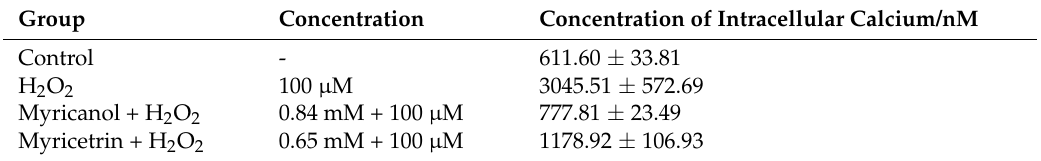
Table 1. Effect of myricanol and myricetrin on intracellular calcium shifts determined by Fura-2-AM probe. Group Concentration Concentration of Intracellular Calcium/nM Control